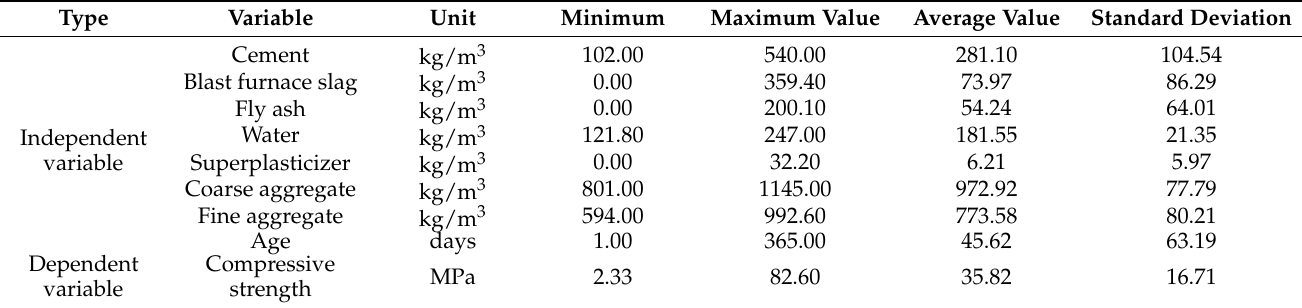
Table 2. Statistical information for CC datasets (data source: